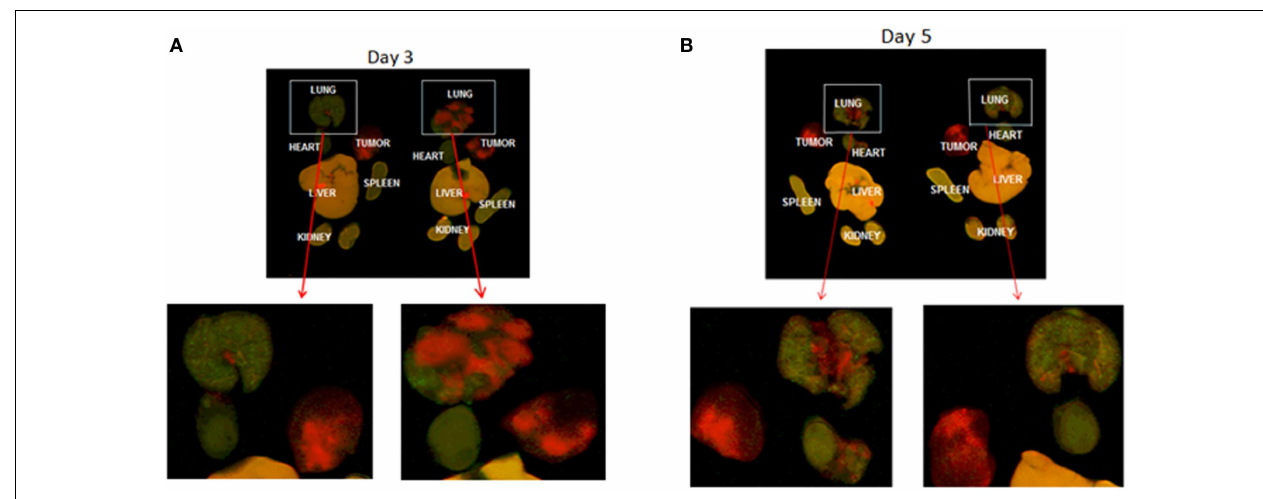
lung on the left does not have metastasis. (B) Day 5 – MSCs are seen engrafted in the lung with small tumors on the top left and no tumor on the top right. Red chest wall primary tumors do not show engraftment.We conclude from this that MSCs home to and engraft in lung but not primary tumor. Magnification of organs without metastasis and with metastasis from primary image (A)